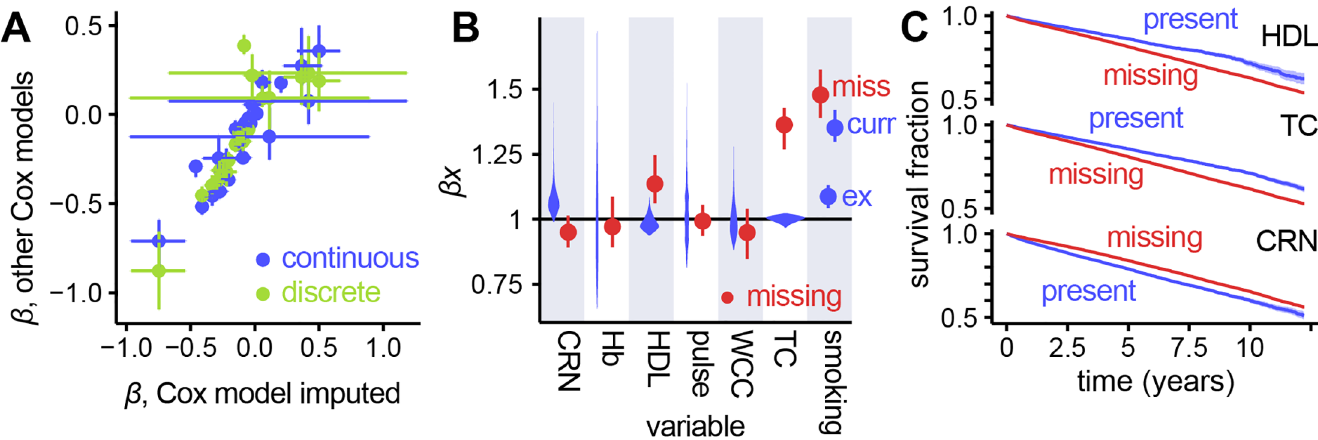
Fig 3. Comparison of coefficients for present and missing data in continuous and discrete Cox models. (A) Fitted coefficients for different Cox models compared. Values of risks from both the continuous model with missingness indicators, and the discretised model are plotted against the continuous imputed Cox model. There are fewer points for the discretised model as coefficients for continuous values are not directly comparable. The very large error bars on four of the points correspond to the risk for diagnoses of STEMI and NSTEMI. This is due to the majority (73%) of heart attack diagnoses being ‘MI (not otherwise specified)’ from which the more specific diagnoses were imputed, introducing significant uncertainty. (B) For the continuous Cox model with missingness indicators, risk ranges for the ranges of values for variables present in the dataset (violin plots) with risk associated with that value being missing (points with error bars). CRN = creatinine, HGB = haemoglobin, HDL = high-density lipoprotein, WBC = white blood cell count, TC = total cholesterol; for smoking status, miss = missing, ex = ex-smoker and curr = current smoker, with non-smokers as the baseline. (C) Survival curves for selected variables, comparing patients with a value recorded for that variable versus patients with a missing value. These can be compared with risks associated with a missing value, seen in (B): HDL and TC show increased risk where values are missing, whilst CRN shows the opposite, which is reflected in the survival curves.